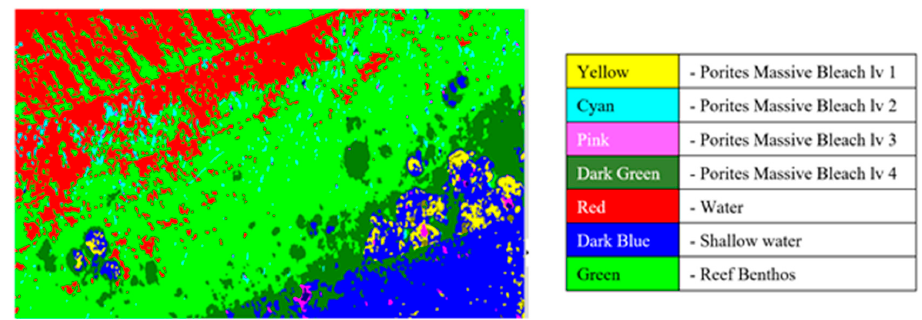
Figure 10. Coral identified with various levels of bleaching.